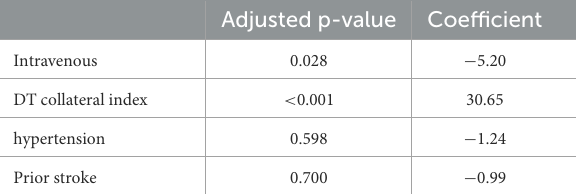
between the two groups (Table 4). No significant between-group differences were detected in 3-month mortality (26.4 vs.